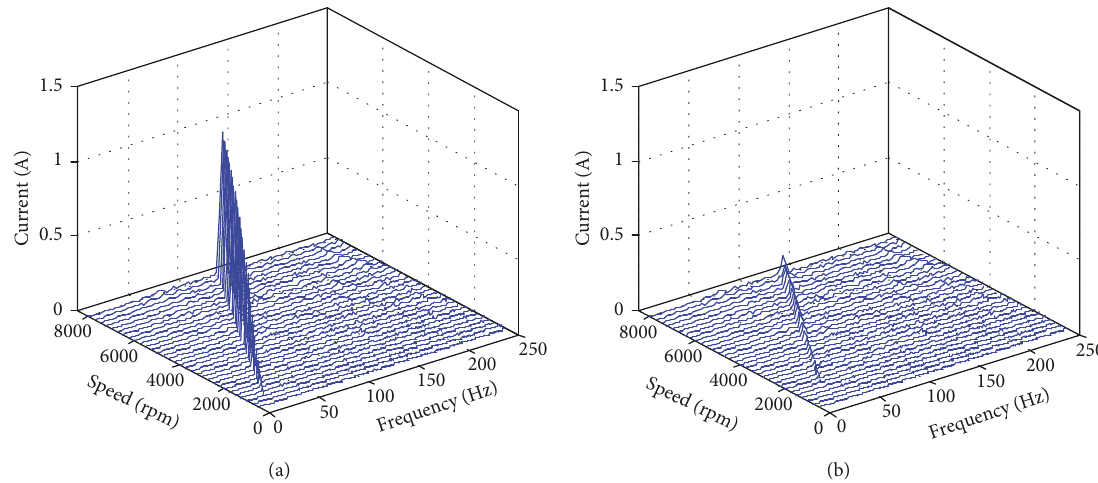
Figure 13: Three-dimensional frequency spectrums of the control current (a) without unbalance control and (b) with unbalance